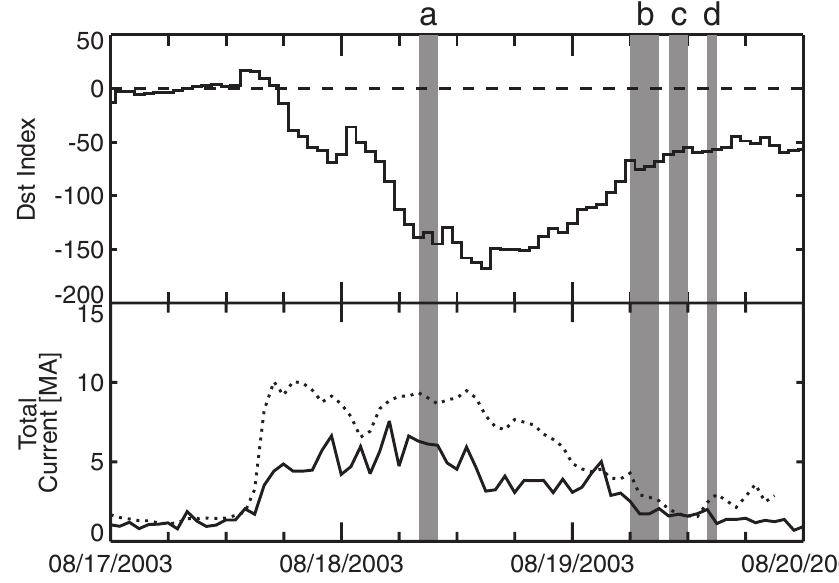
Fig. 7. D st Index and hemispheric total currents from Iridium (solid line) and LFM (dotted line) for the 17–19 August 2003 magnetic cloud. The intervals shown in Fig. 2 are gray shaded.